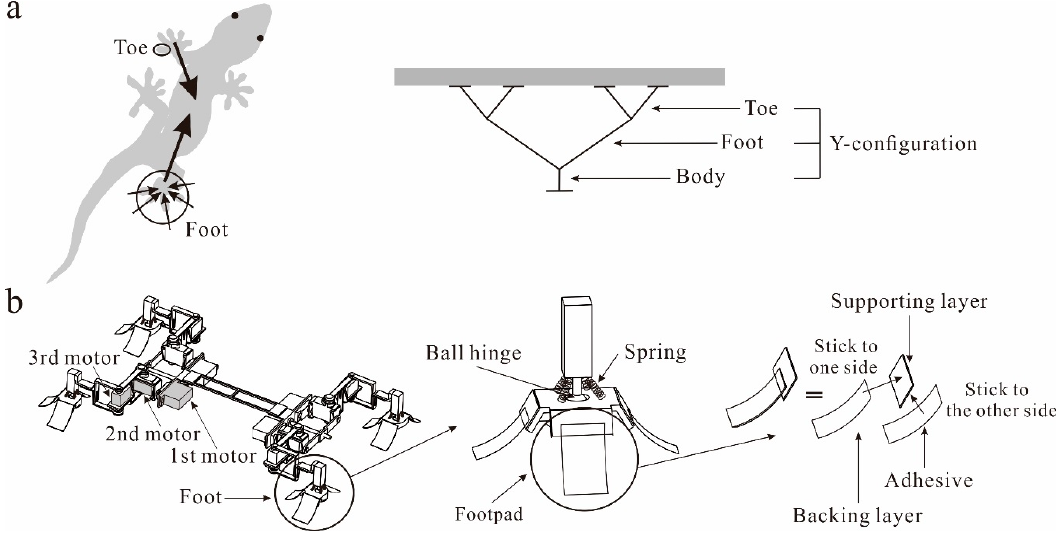
Figure 2. ( a ) Arrangement of toes in the gecko walking on a ceiling surface reveals the utilization of a particular Y-configuration in both toes and feet; ( b ) Mechanical structure of the legged robot and